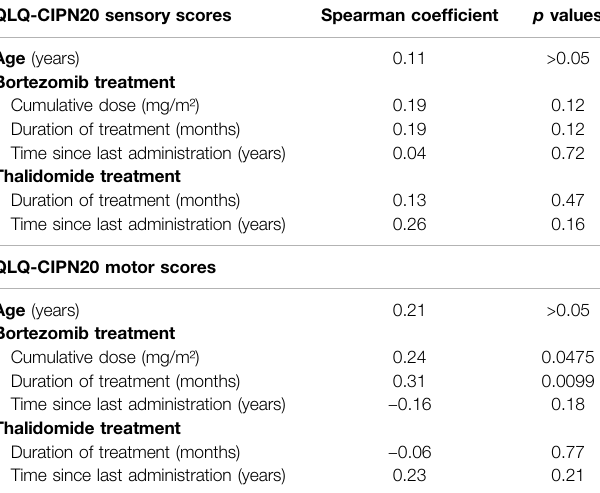
TABLE 2 | Correlations between quantitative variables and the sensory scores of the QLQ-CIPN20 and the motor scores of the